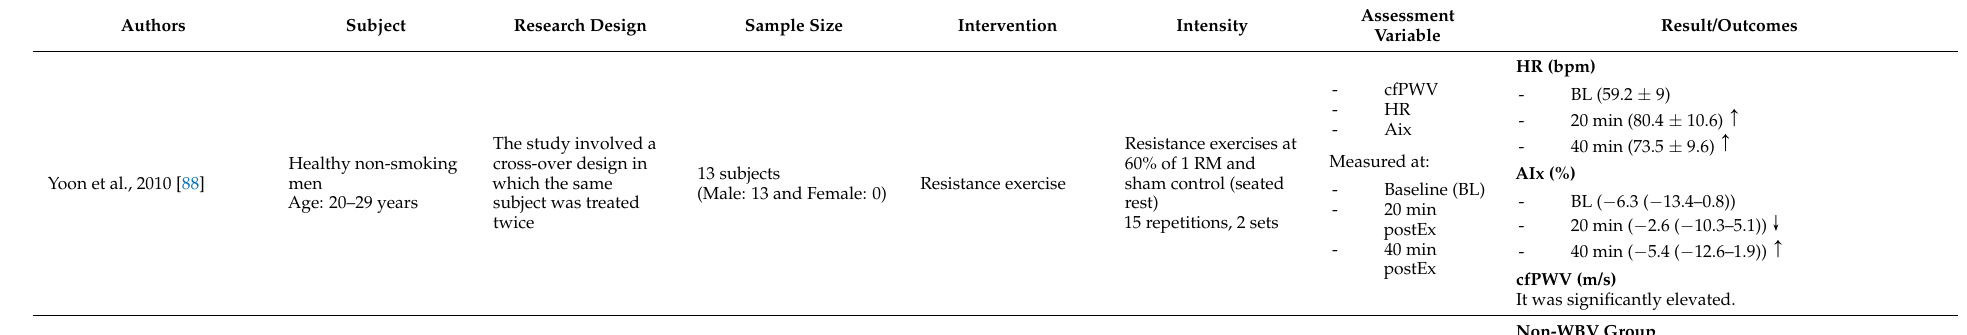
Table 2. Effect of aerobic exercise training on arterial stiffness.